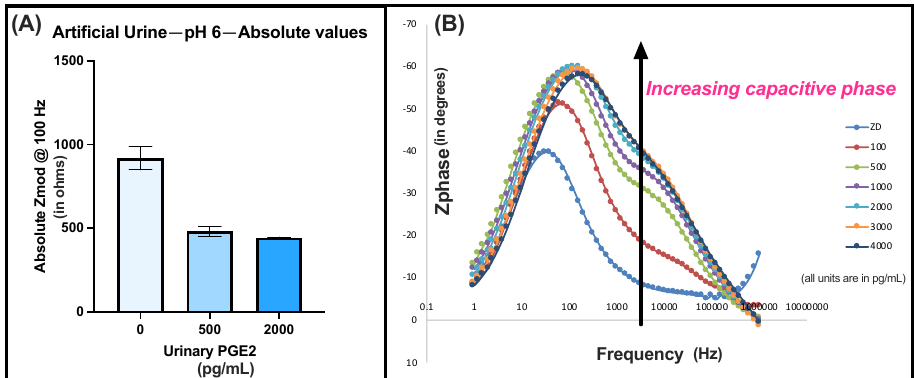
Figure 3. ( A ) EIS response of the developed sensor in synthetic/artificial urine (pH 6) and ( B ) Bode phase plot of the developed sensor showing a dose-dependent increase in capacitive phase in real pooled human urine